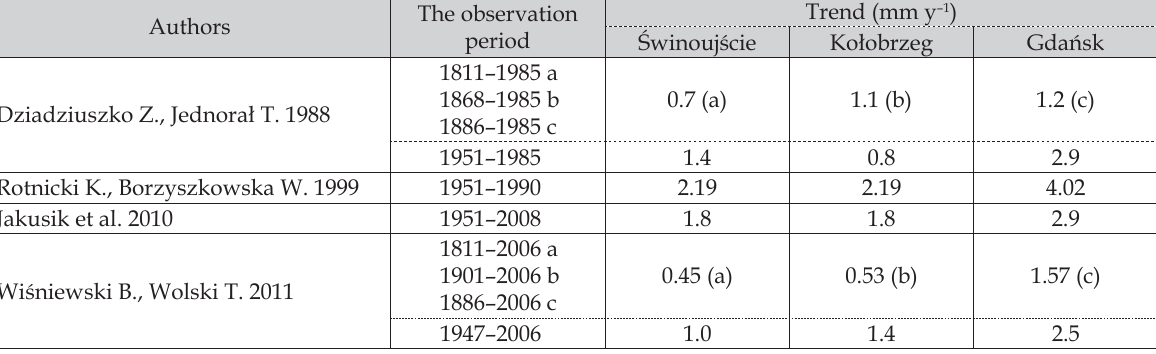
Table 5. The results of some evaluations of trends of average sea level on the Polish